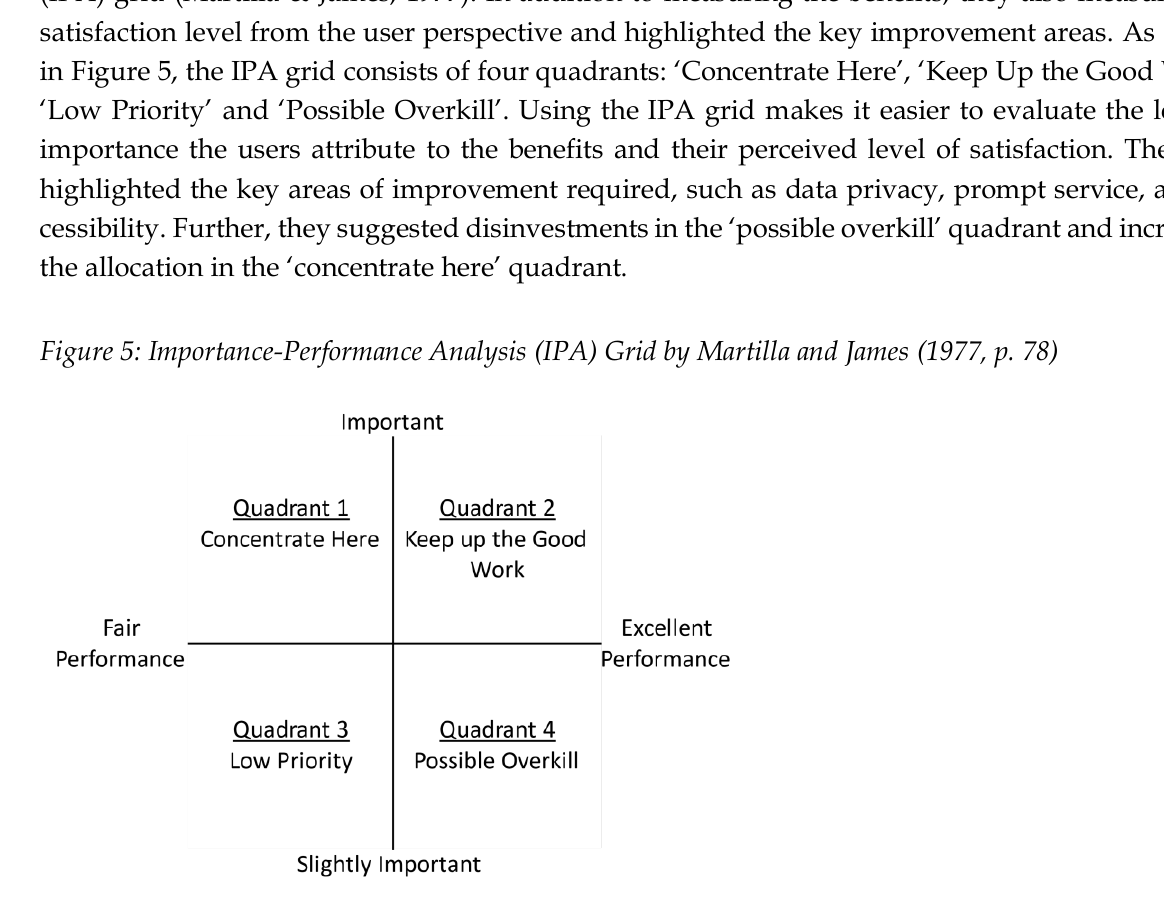
Goel et al. (2012) carried out a case study of e-governme nt adoption at “Haryana Urban Devel- opment Authority” (HUDA) using a dynamic “SAP -LAP (Situation, Actors, Process, Learning,